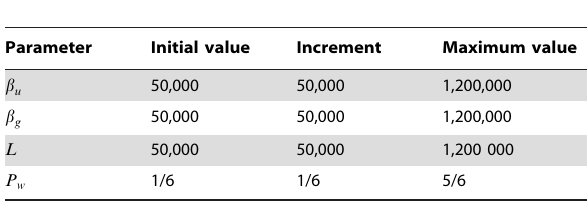
Table 1. Configuration parameters for fingerprint insertion.